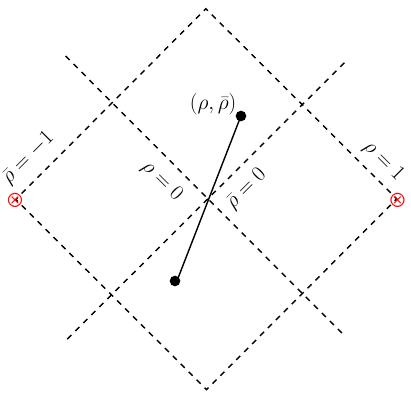
Figure 6 . The bulk channel (cid:26) coordinates de(cid:12)ned in [17]. The defect is a sphere and crosses the plane at the location of the two red dots. The operators are drawn in the time-like con(cid:12)guration that corresponds to 0 < z < 1 = (cid:22) z < 1, that is the region of integration in eq. (3.42). In the region 0 < (cid:26); (cid:22) (cid:26) < 1 the bulk-channel OPE has the following structure, for a